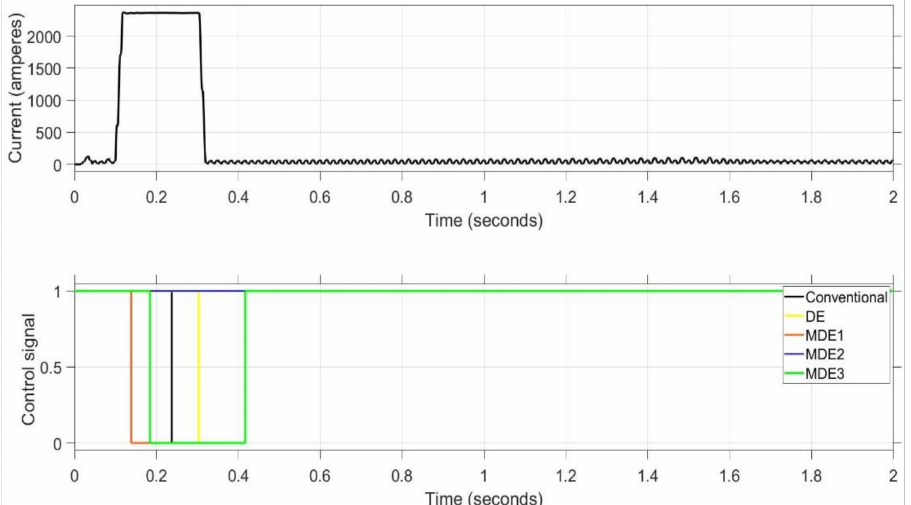
Figure 6. Fault clearance with conventional and optimum settings for no distributed generation voltage